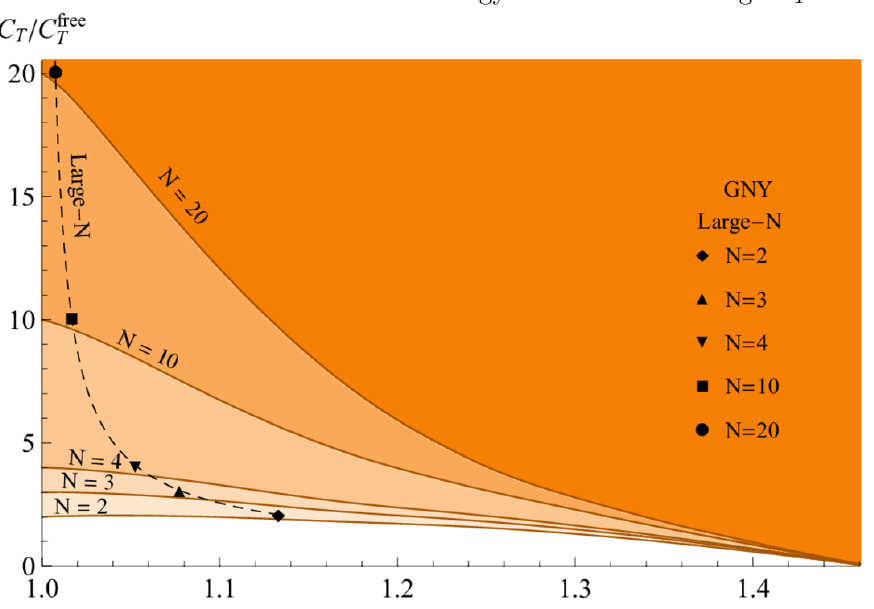
Figure 7 . Lower bounds on the stress energy tensor central charge C T as a function of the scaling dimension (cid:1) of the fermion transforming in the O ( N ) fundamental representation. We normalize the central charges C T such that as (cid:1) ! 1, we set the value of C T to be equal to the number of fermions in the theory. The black markers are large- N estimates for GNY models obtained up to O (1 =N 2 ) corrections